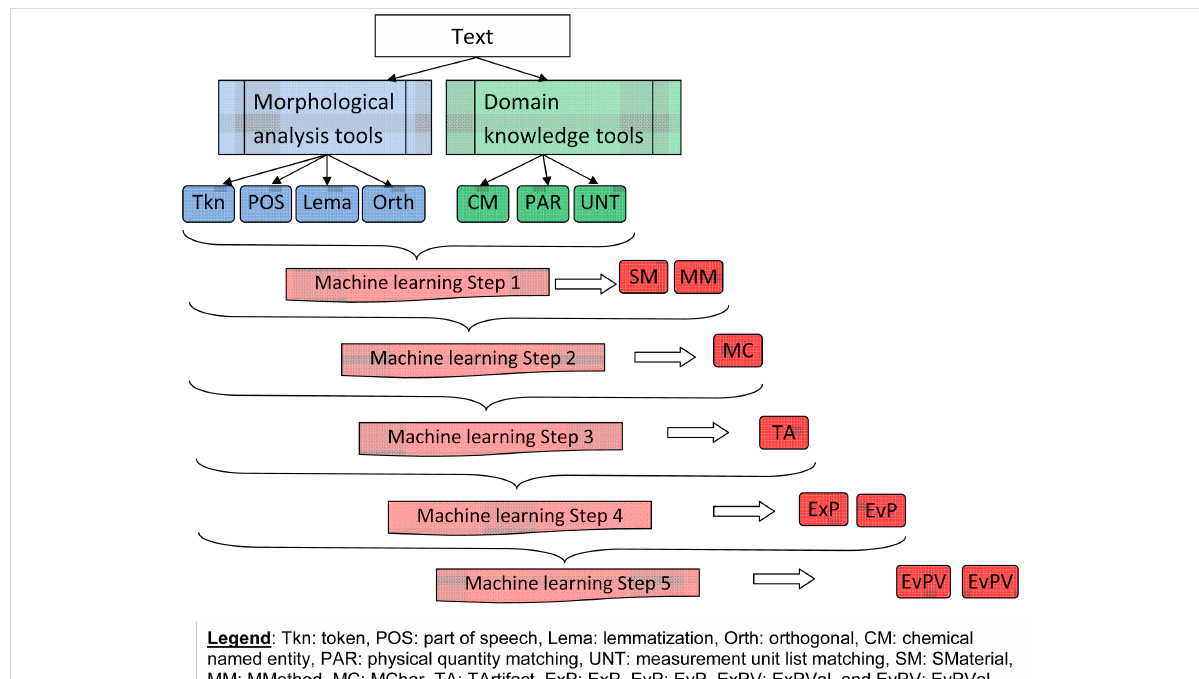
Figure 3: Outline of our automatic information extraction system.